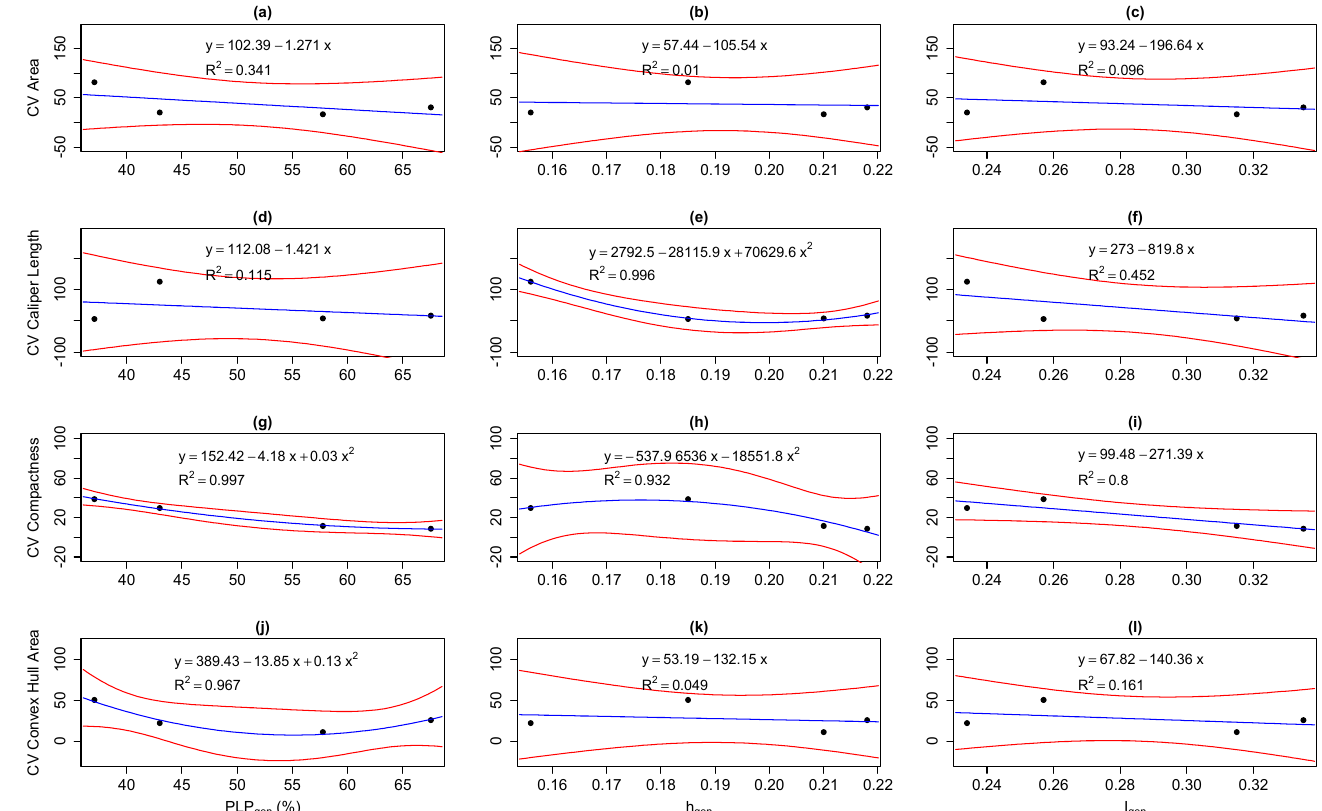
Figure 5. Relationships between intra-population epigenetic diversity and phenotypic variation of sweet cherry pre-defined populations ( n = 4). The dots represent the observed mean values per population, the blue lines represent the model fit, and the red lines correspond to the lower and upper limits of the 90% confidence intervals. The fitted model and the corresponding R 2 are also displayed ( a – l ).